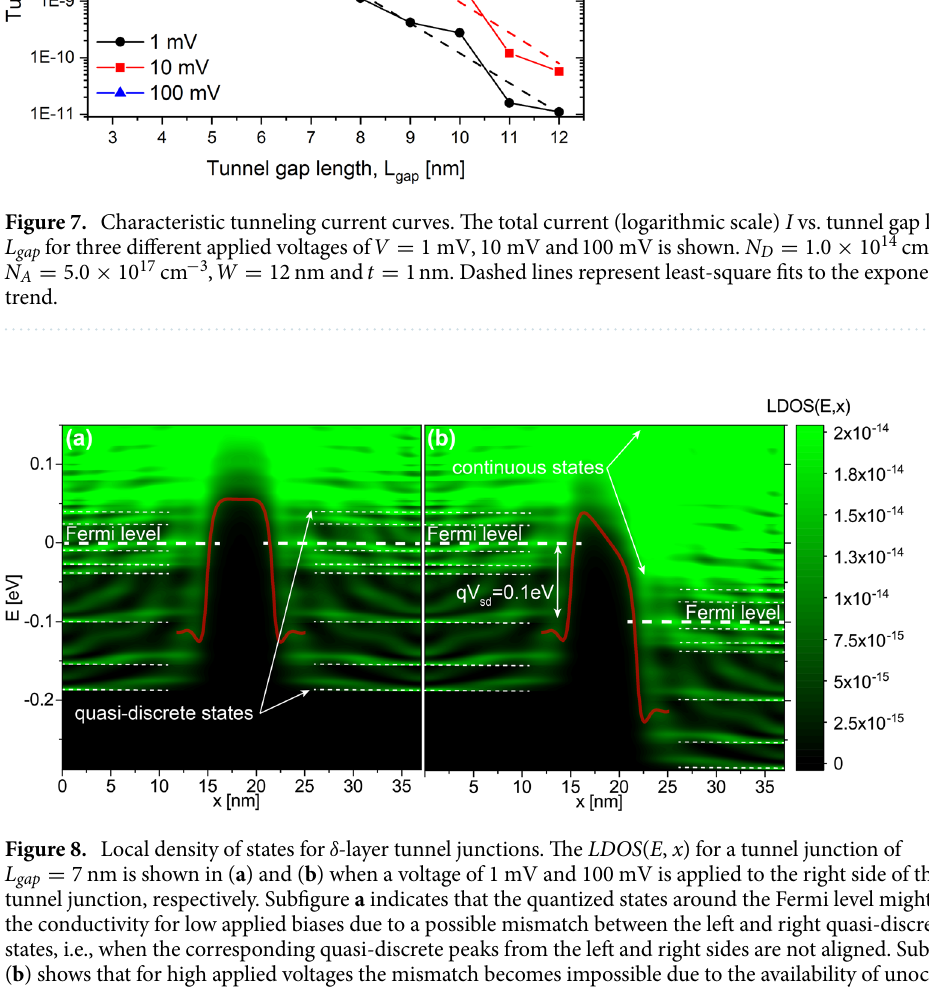
3 , W 2 , N 12 nm and 1.0 10 14 cm 5.0 10 17 cm A = − − = = × ×